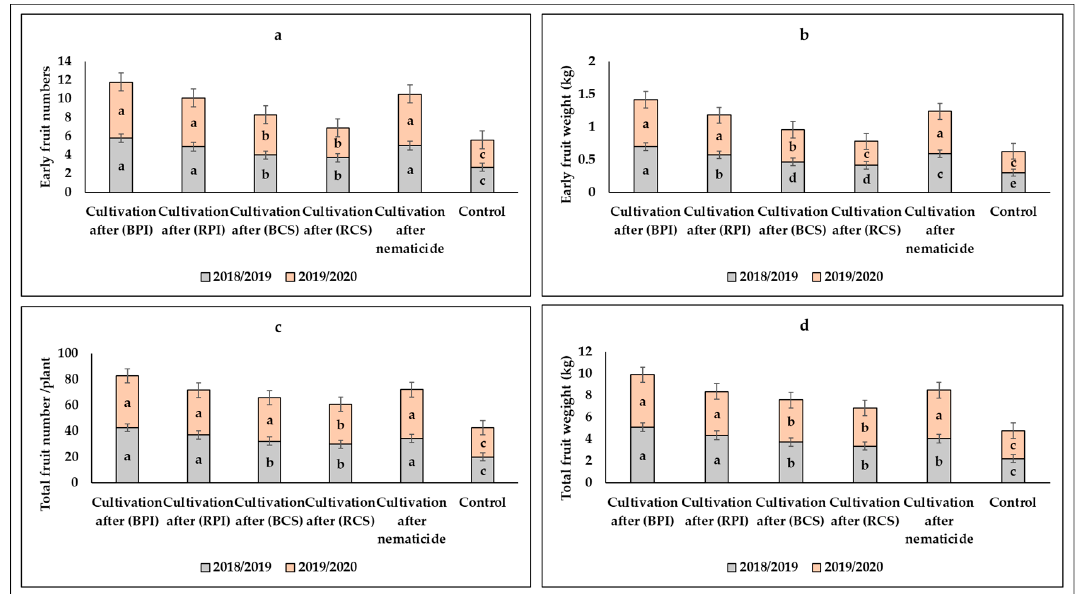
Figure 4. The effects of biofumigation, crop sequence, nematicide treatments compared with control on cucumber yield and its component, in two seasons 2018/2019 and 2019/2020. (( a ) Early fruit numbers, ( b ) early fruit weight (kg), ( c ) total fruit numbers, ( d ) total fruit weight (kg)). Means ( ± SE) followed by the same letter are not significantly different at p ≤ 0.05 (LSD test).